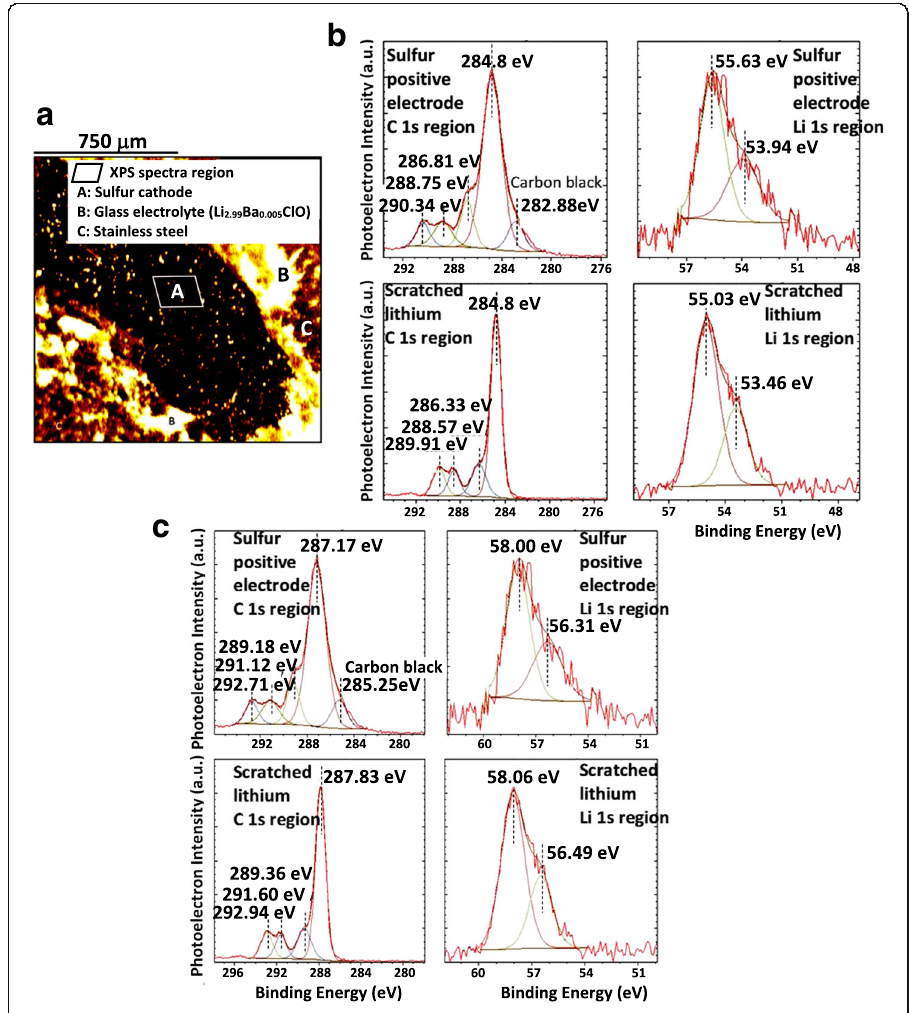
Fig. 9 a XPS image with the analyzed positive electrode surface from Fig. 8b. b XPS profile spectra showing carbon and lithium peaks for the lithium positive electrode ( a analyzed surface) and glove box-scratched lithium metal (pristine reference not used as anode) using adventitious carbon peaks as reference; c XPS profile spectra as